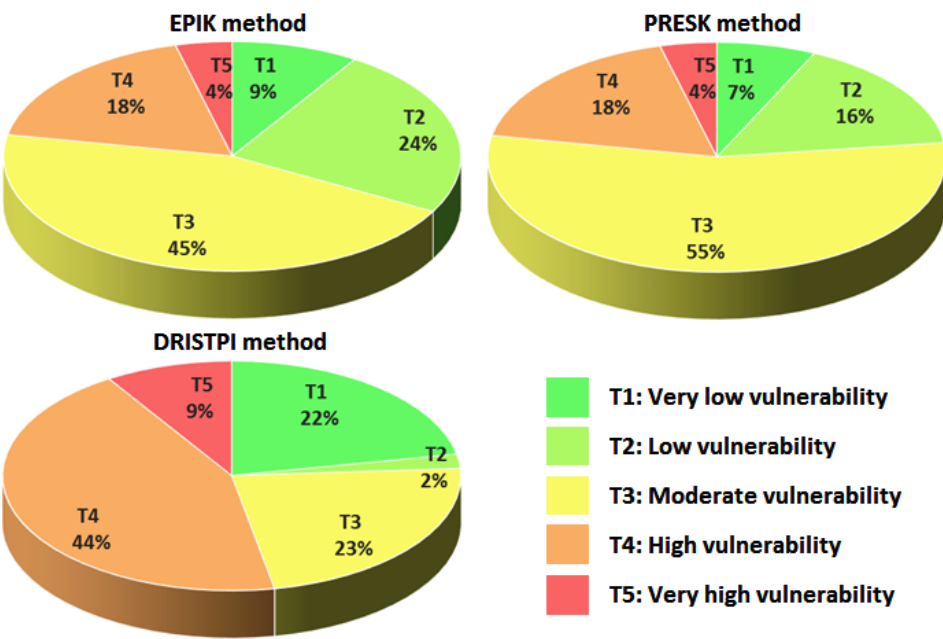
Figure 8. Vulnerability class